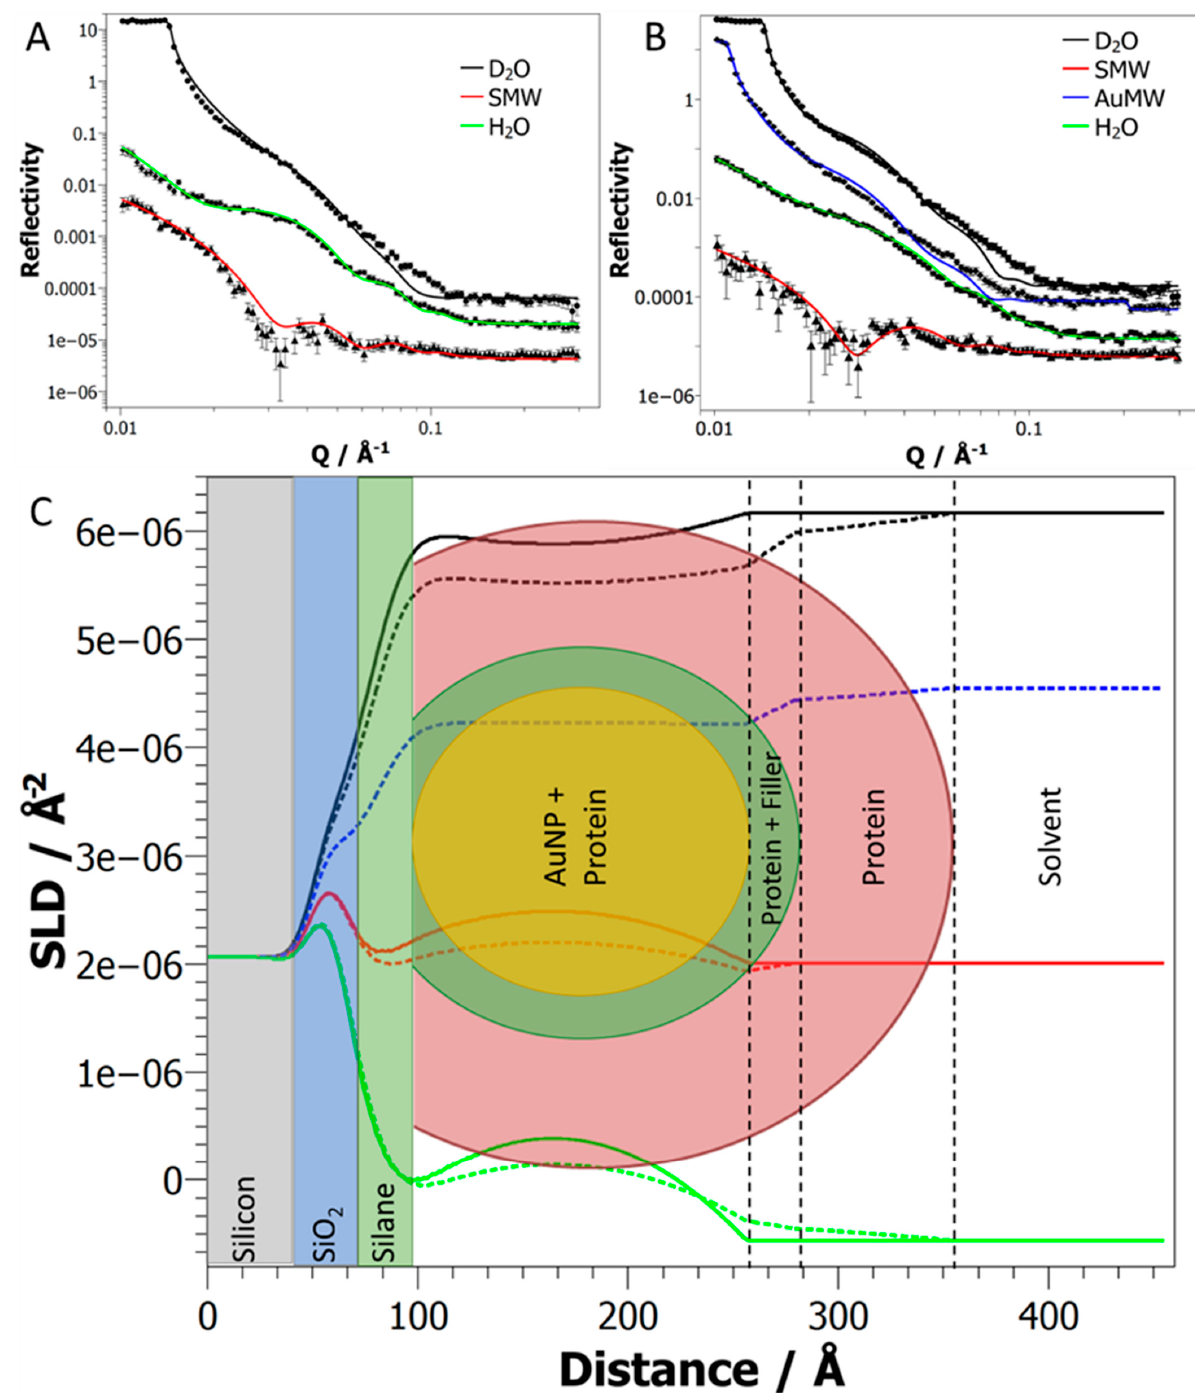
Figure 3. Data fitting and corresponding SLD profiles generated using the sphere model for the AuNP surface before and after GGzOmpATM assembly. ( A , B ) Reflectivity data for AuNP and AuNP + GGzOmpATM surfaces, respectively, with the model fits represented by solid lines and the reflectivity profiles offset for clarity. ( C ) The resulting SLD profiles from the fits of the reflectivity data. Both of the SLD profiles have been overlaid with the solid and dashed lines representing the AuNP and AuNP + GGzOmpATM surfaces, respectively. The colors represent the different solvent contrasts used; D 2 O, SMW, AuMW and H 2 O. A schematic representation of the layer structure is also overlaid, which shows the composition of the different regions of the SLD profile. NB 1e-06 has been used to indicate 1 × 10 − 6